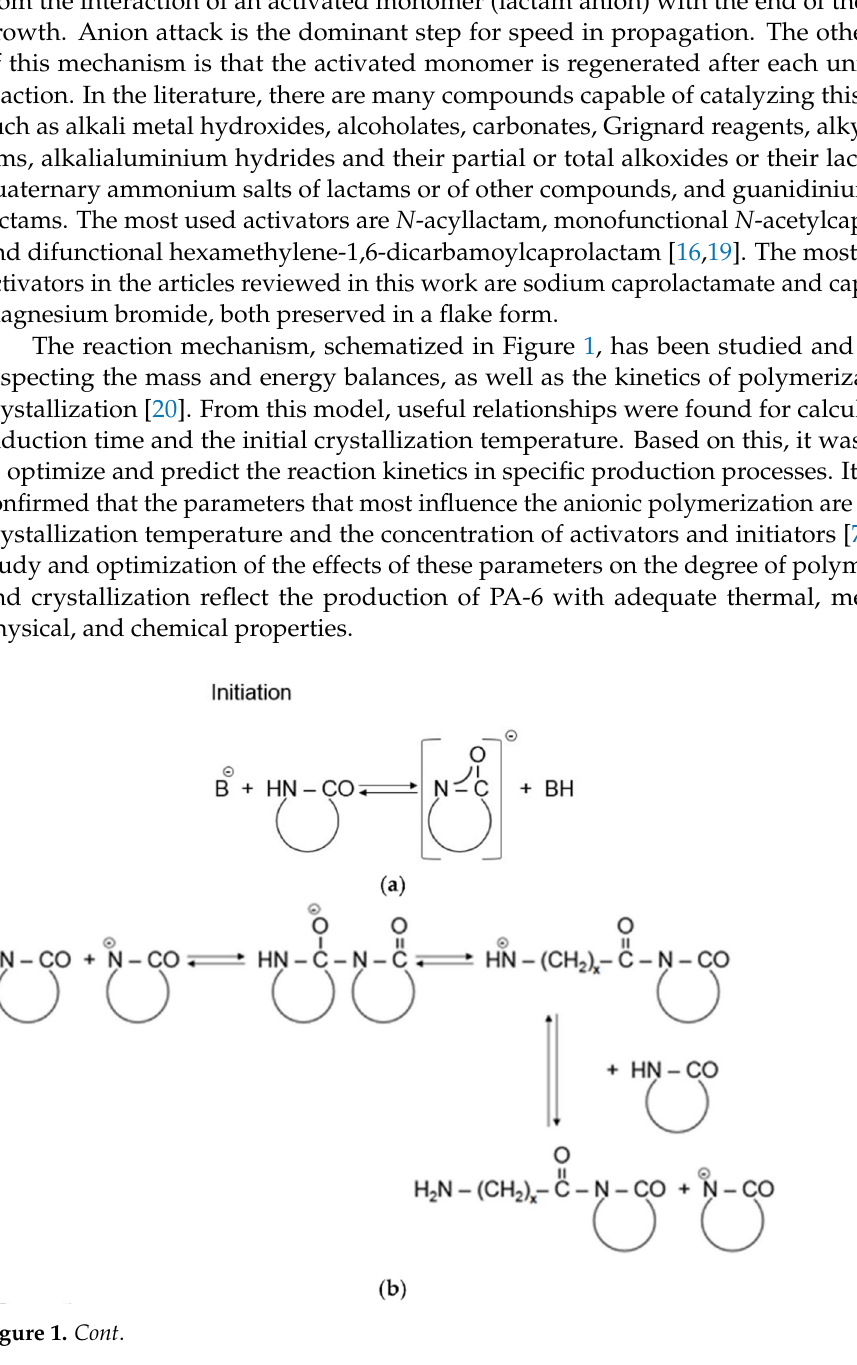
Figure 1. Initiation ( a , b ) and propagation ( c ) of the AROP of lactams, schematically. Note: x = 5 and 11 for CL and LL, respectively. Reprinted from Reference [18], under open-access license. In addition to the performance aspect, industries require materials that come from green processes. Under certain conditions, the anionic ring-opening polymerization reac- tion proceeds at high conversion rates and with negligible wastes of matter. Beyond being green, this process has epsilon caprolactam as its reagent, which can be synthesized from renewable sources [21–23] and produces a polymer (PA-6) that can be returned to the starting monomer and is, therefore, recyclable. 3. In Situ Polymerization The possibility to have a powdered reagent that can synthesize PA-6 in minutes has enabled the massive development of many techniques, including in situ polymerization [24]. In the production of nylon objects starting from polymer, there are criticalities in the rheology of the fluid due to its high viscosity [25]. Starting from the monomer in the form of flakes, however, it is possible, by heating, to obtain a much less viscous monomeric fluid that polymerizes in a semi-crystalline form in a range of 140/180 °C [12]. In this case, the temperature influences the degree of polymerization and crystallization at the same time. At high temperatures, the polymer produced has a high molecular weight but a high amorphous fraction and vice versa [12]. For most applications and experiments, the opti- mal process temperature is 140/150 °C [26]. For each technique, the optimization of the process was investigated with the right temperature, the right concentration of activators and initiators, and ensuring the absence of water in the entire process.